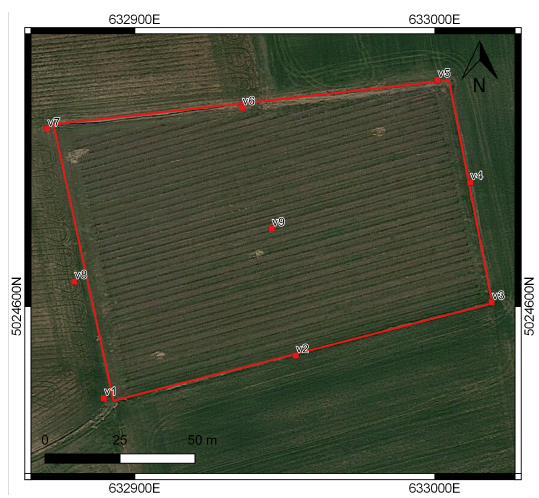
Figure 2. Ground Control Points’ (GCPs) distribution for the surveys on the vineyard. Map data: c (cid:13) Google